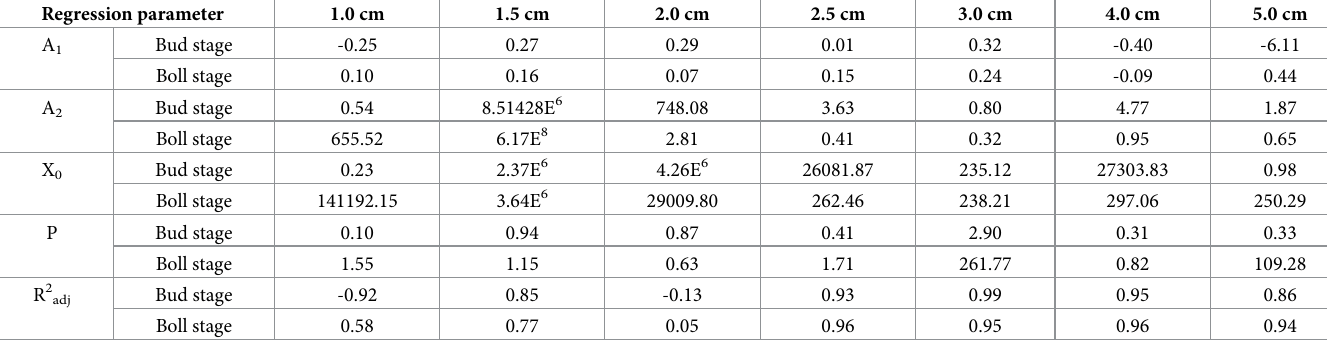
Table 7. Regression parameters of the logistic equations between the boll falling rate and hail fall density. Regression